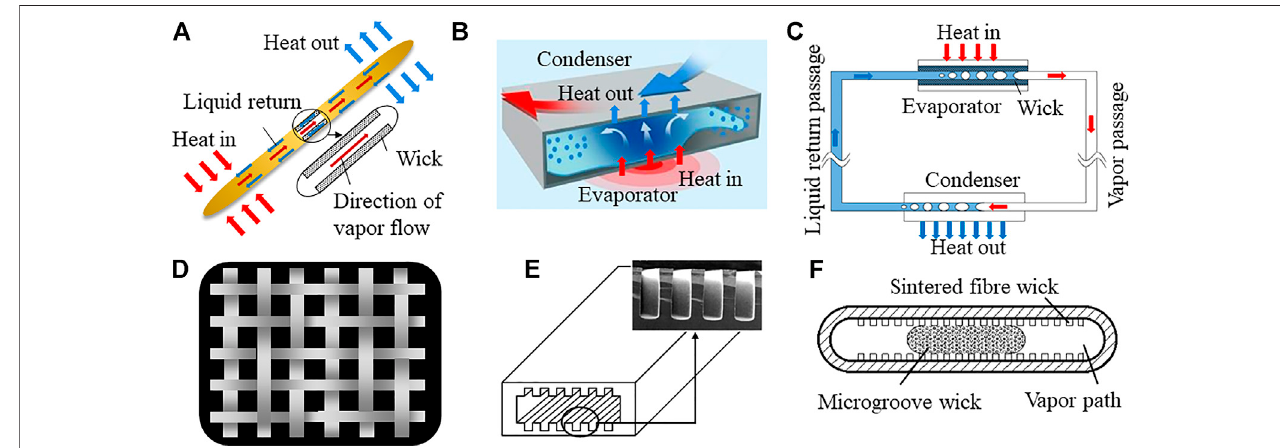
FIGURE 1 | Schematic diagram of UTHP: (A) FHP, (B) VC, (C) UTLHP, (D) sintered wick structure, (E) microgrooved wick structure (Gillot et al., 2003), and (F) composite wick structure (Li et al.,